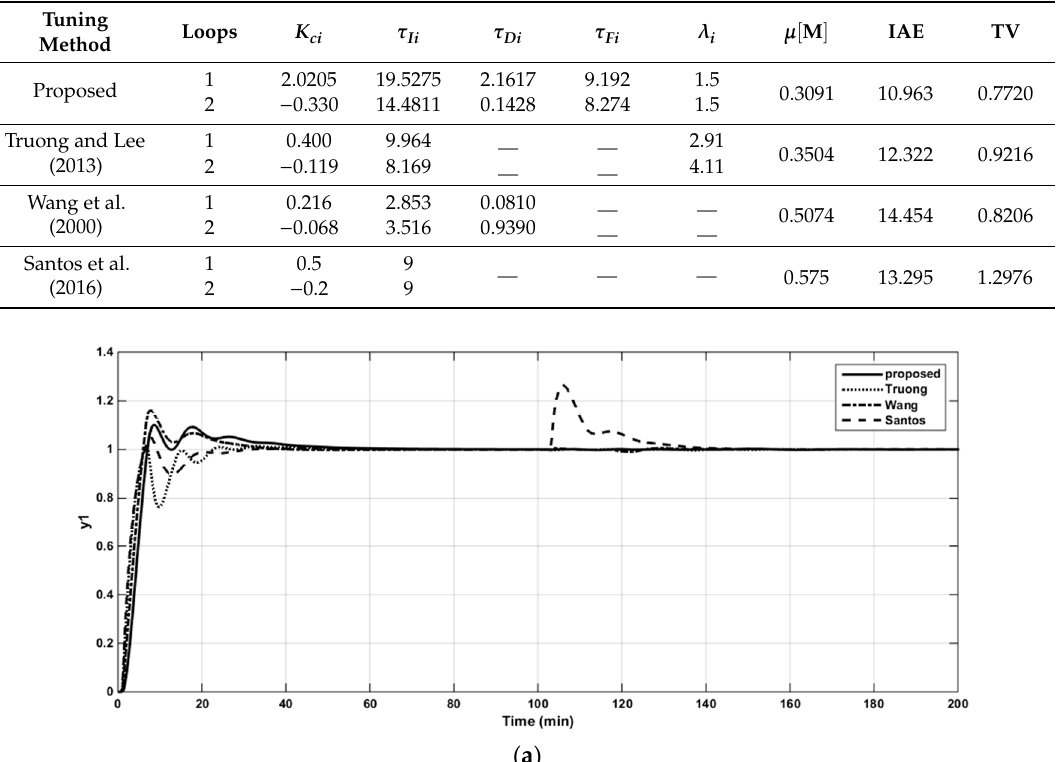
( b ) Figure 10. Closed-loop responses to the unit step changes in the set-point of loop 1 ( a ). Closed-loop responses to the unit step changes in the set-point of loop 2 ( b ). ( a )